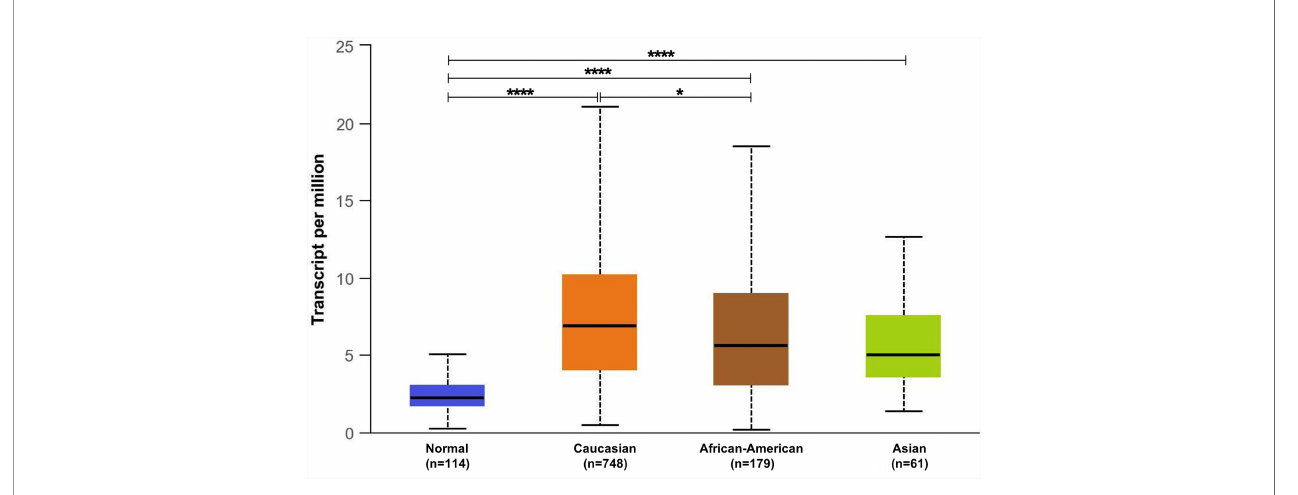
FIGURE 5 | In-silico analysis of GPR68 expression across the different ethnicities (Caucasians, African-American and Asians) of breast cancer patients compared to normal breast samples. *p<0.05 and